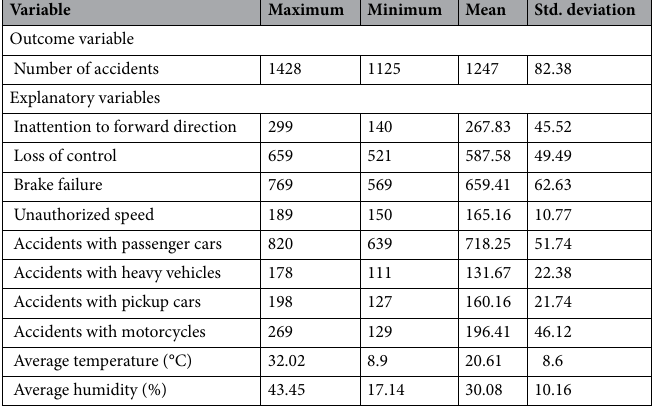
Table 1. Descriptive statistics of RTA data.